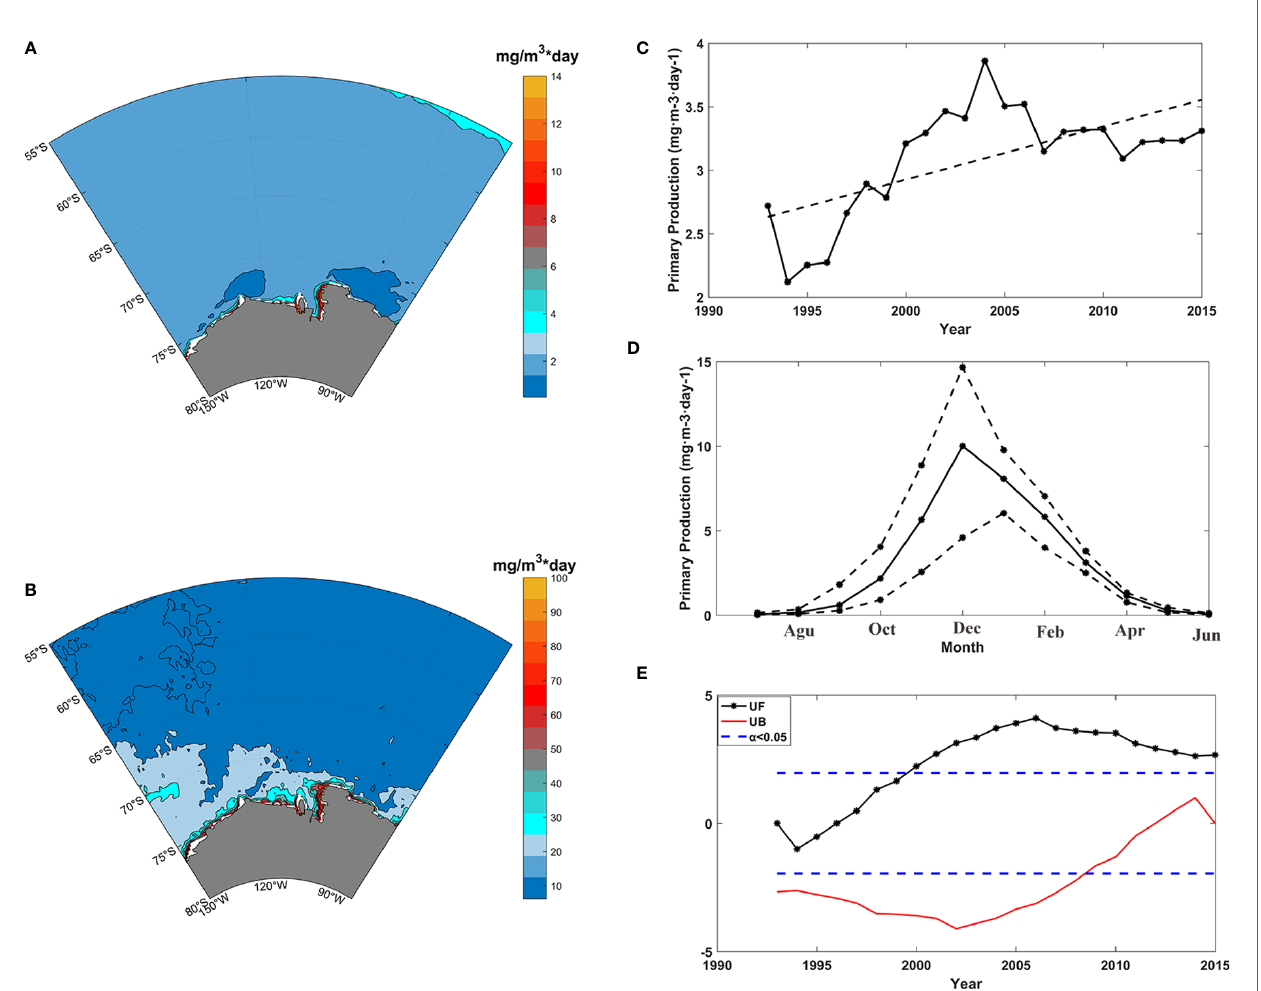
FIGURE 2 | Primary production in the Amundsen Sea, (A) mean value of primary production from 1993 to 2015; (B) seasonality amplitude of primary production; (C) annual values of (black line) and long-term changes in (black dashed line) primary production; (D) MK-values (y-axes) obtained from the sequential Mann-Kendall test against time for annual primary production, the black line represents the progressive UF(t) and the red line represents the retrograde UB(t) ; (E) monthly primary production values (black line) and amplitudes of the monthly values (black broken